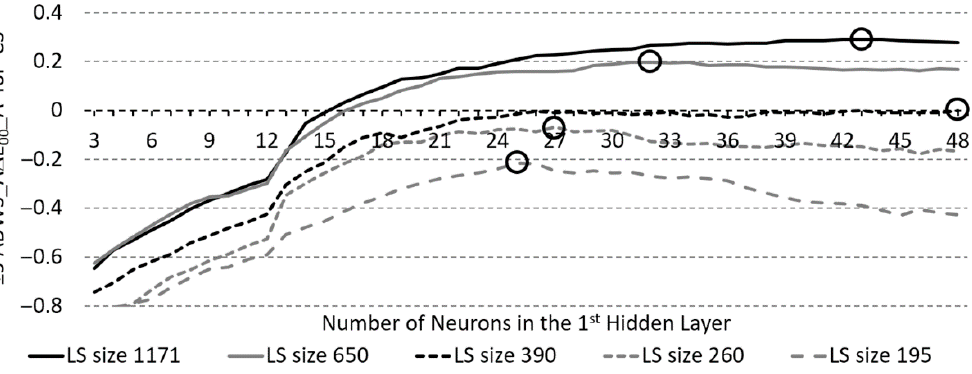
Figure 11. Average of ±9 number of neurons (NoN) neighbourhood of Difference between “slight”– ”noticeable” perception margin and the Weighted sum of average CIEDE2000 colour differences with illuminant A (±9 ADWS_A ∆ E* 00 _A), for the third single camera (C3 = GH4), and LM learning algorithm, with marked maximum values, according to different learning set (LS) sizes.